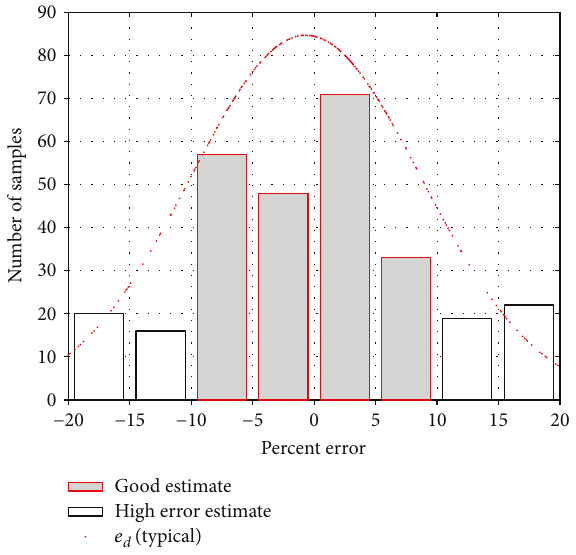
Figure 6: Comparison between the experimental thrust and estimated thrust for 291